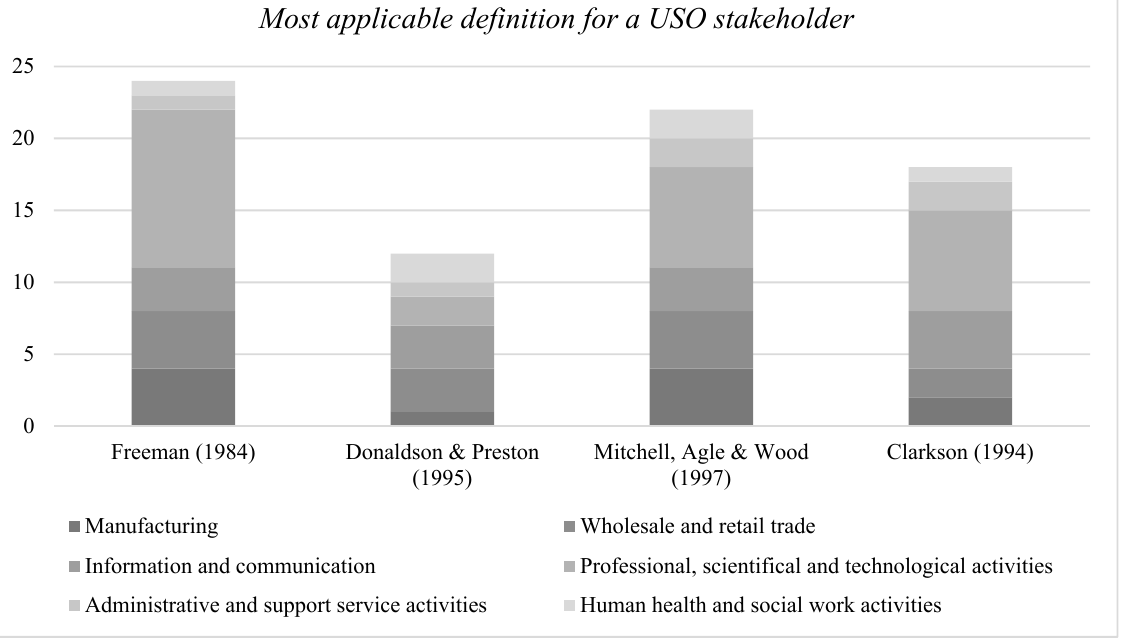
Figure 6. Most applying definition for a USO stakeholder (Freeman 1984; Donaldson and Preston 1995; Mitchell et al. 1997; Clarkson 1994).